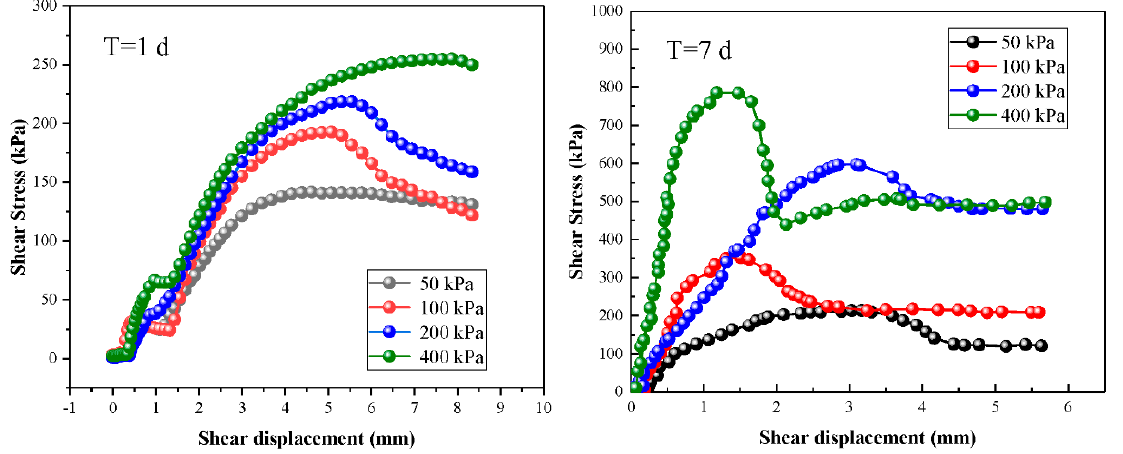
Figure 3. Relationship curve between shear stress and displacement of MS9 modified dredged sludge sample.